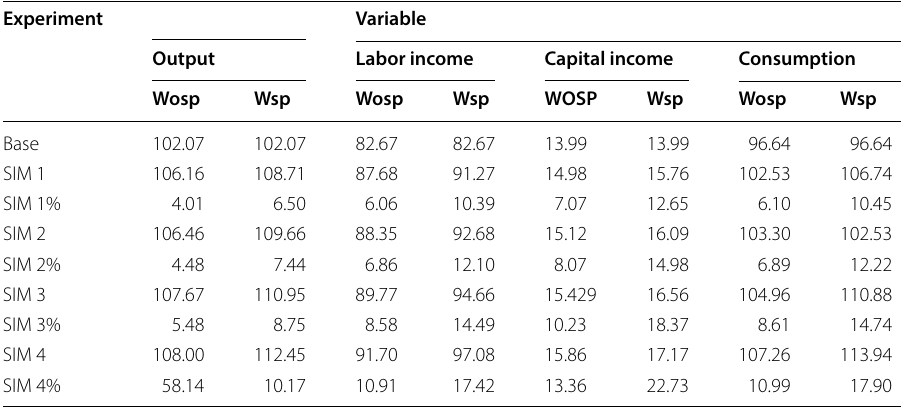
Table 4 The impact of joint implementation of policies on the regional output Source: own computation result based on Oromia region